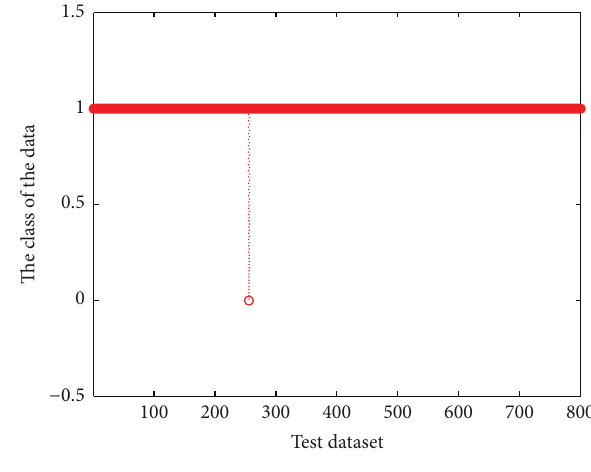
Figure 7: The SVM for fault detection for fault 4.